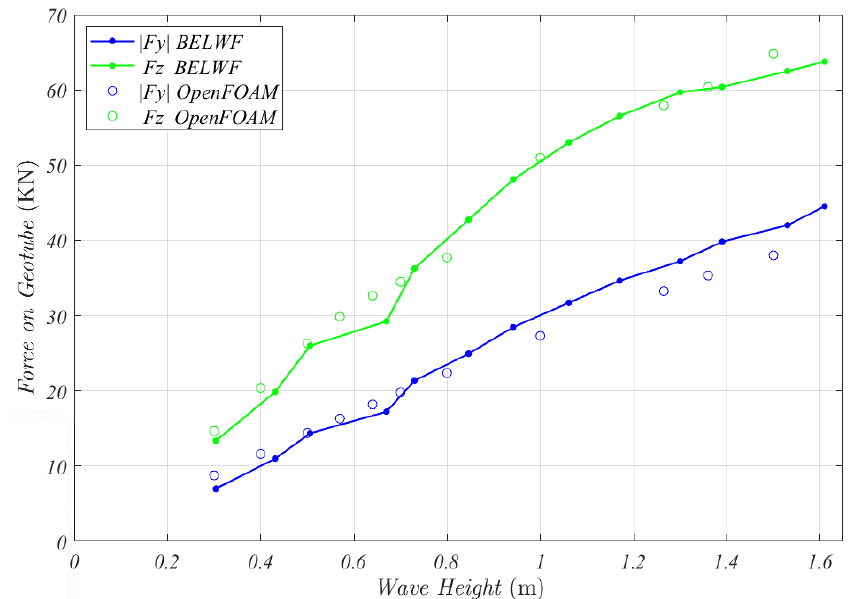
Figure 5. A comparison of the wave forces applied to the Geotube, versus wave height; between BELWF and OpenFOAM.